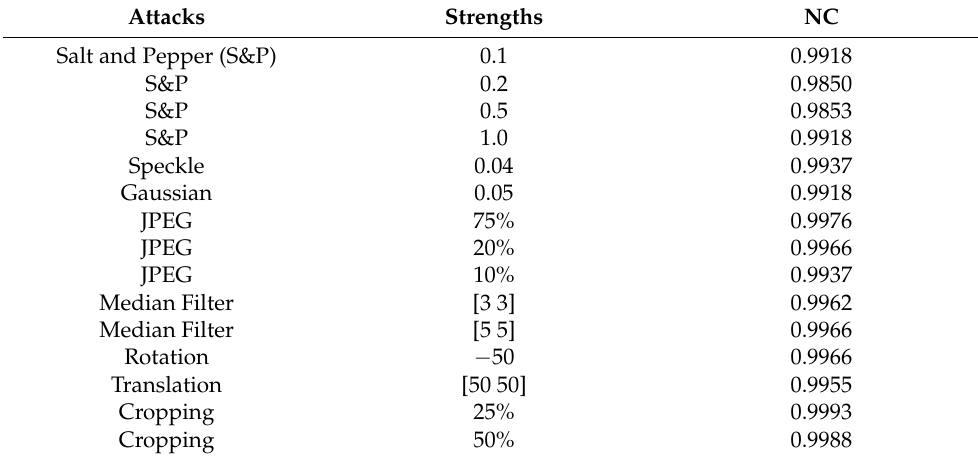
Table 4. Normalized correlation strength.